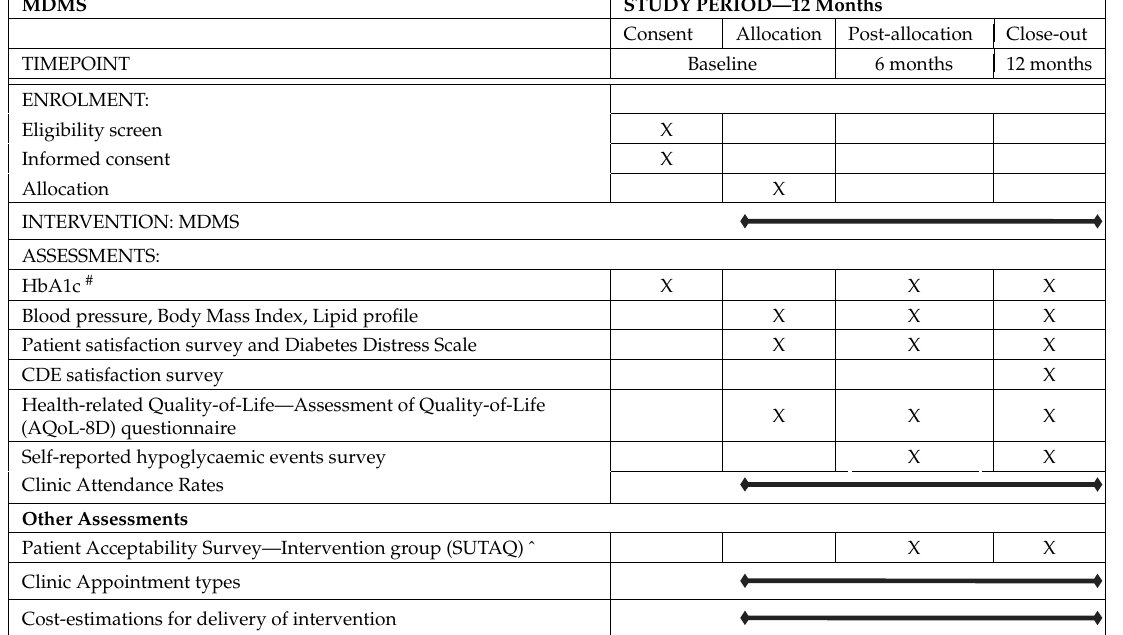
Table 1. Schedule of Enrolment, Intervention and Assessments.